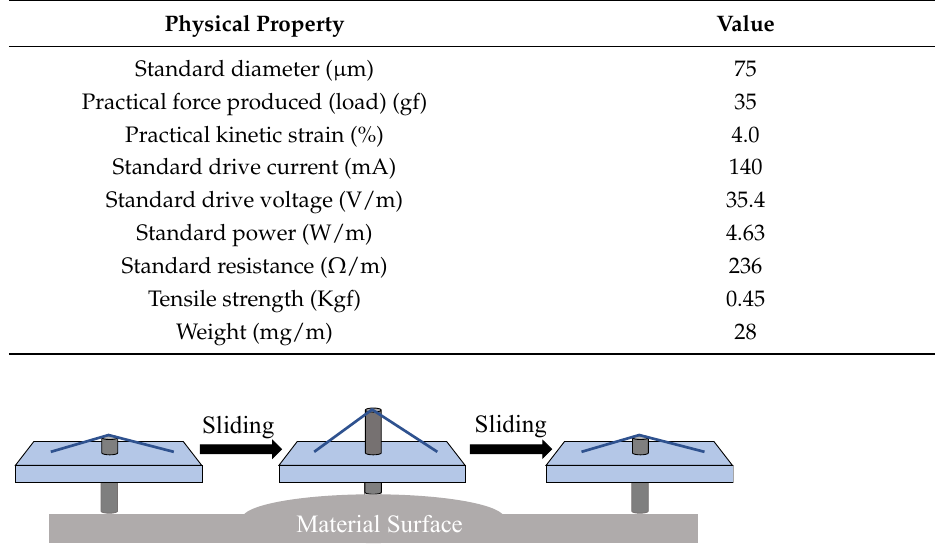
Figure 4. SMA sensor for sensing micro-force. Table 1. Physical properties of BMF75.